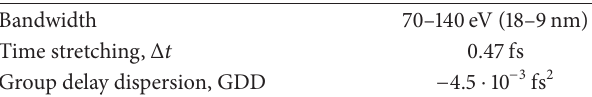
Table 2: Requirements for the attosecond compressor.